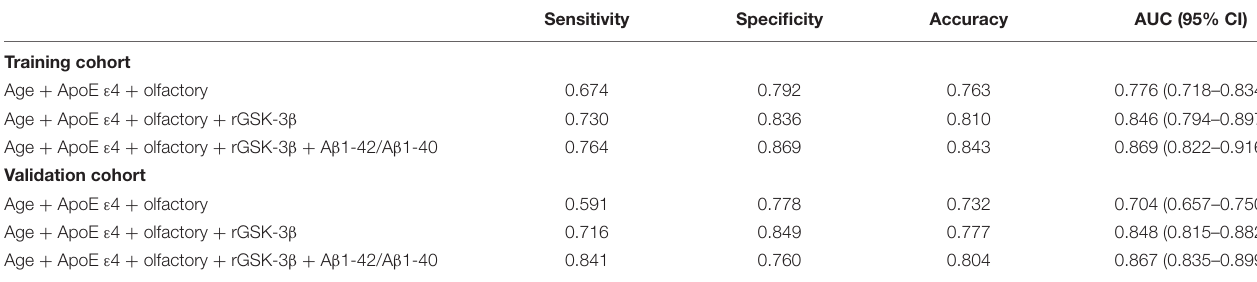
TABLE 4 | Diagnosing efficacy of the combined